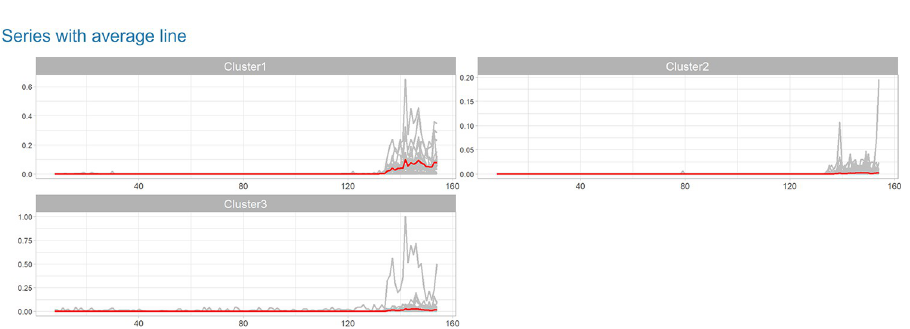
Fig 3. Clustering and forecasting Taiwan COVID-19 confirmed infection cases—Part